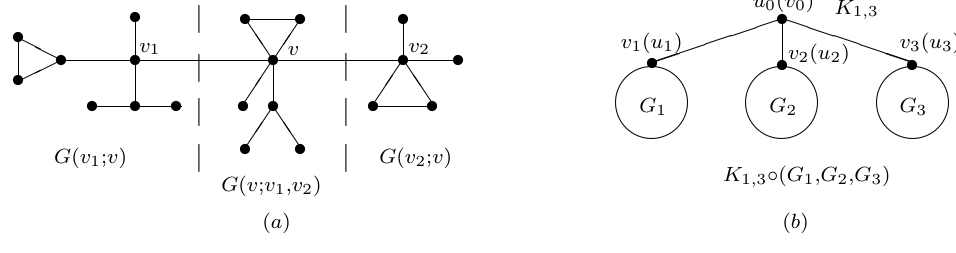
Fig.4. Illustrations of Definition 2 . 1( i ) and ( iii ) Figure 4. ( a , b ) Illustrations of Definitions 1 ( i ) and ( iii )